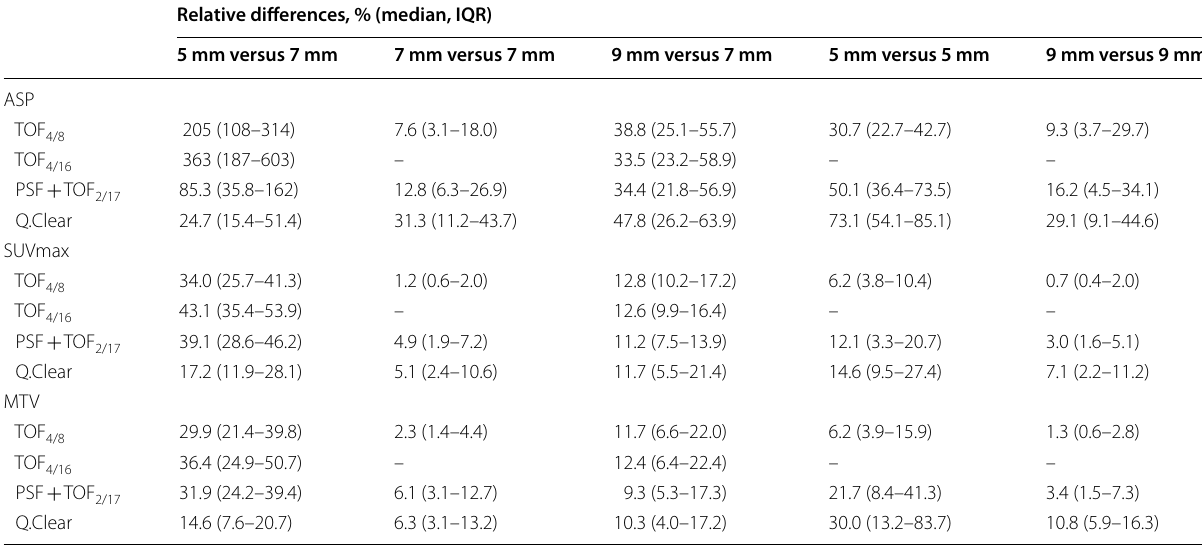
Relative differences in % (with interquartile range; IQR) are given for each algorithm relative to the reference algorithm TOF 4/16 . Different pairs of reconstructed spatial resolution (FWHM) are compared. Missing values reflect pairs of identical datasets